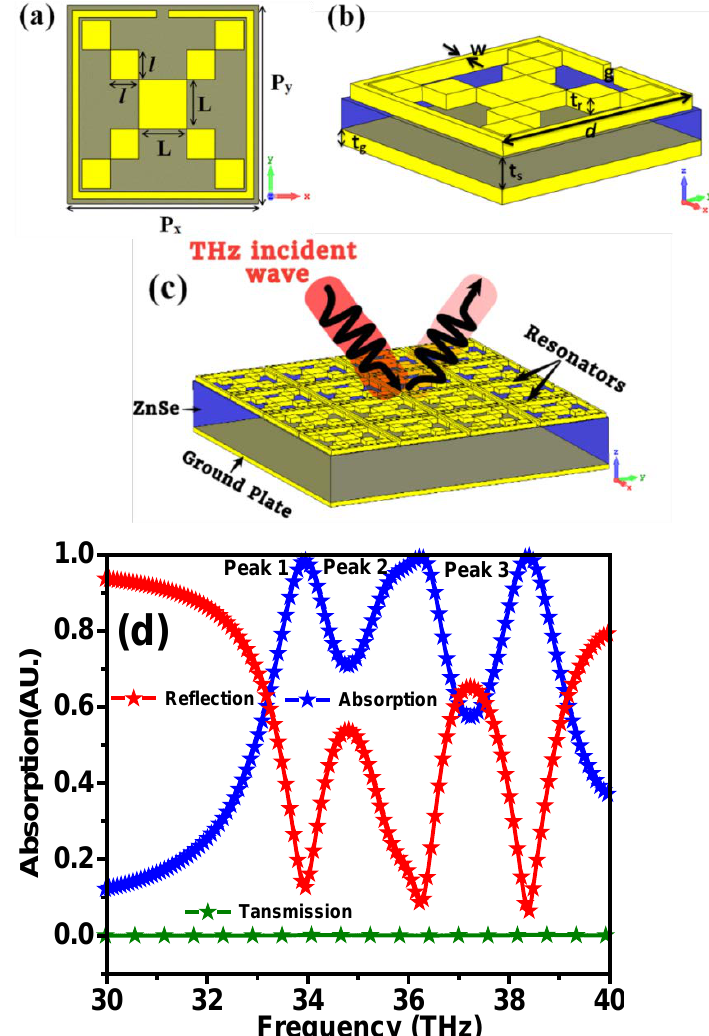
Figure 1. ( a ) Top view of the proposed design, ( b ) perspective view, ( c ) the 4 × 4 array unit cell showed all layers with incident THz, and ( d ) simulated absorption, reflection, and transmission